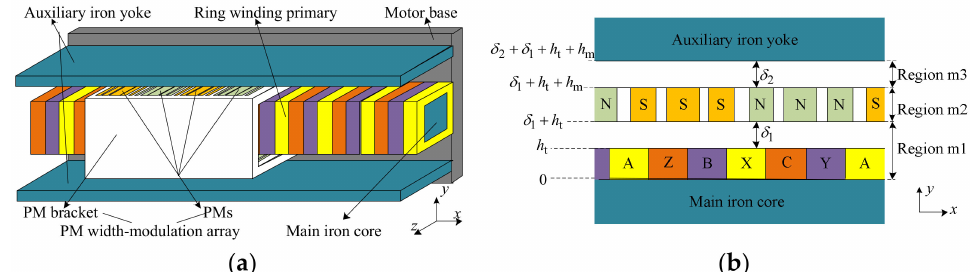
Figure 2. Model of the double-sided PMLSM with the PM width-modulation array: ( a ) motor structure, ( b ) unilateral analytical model for electromagnetic